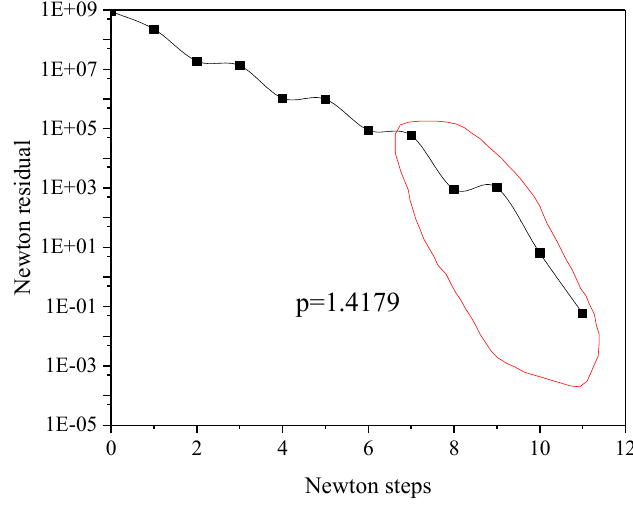
Figure 4. Newton residuals in the calculation process.